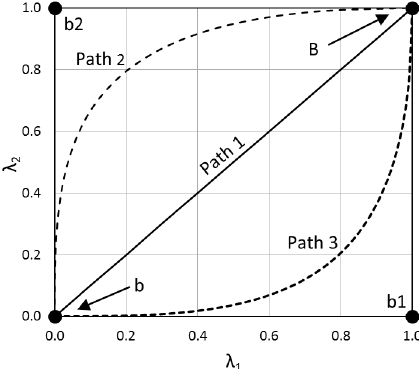
Figure 1. Three possible integration paths when the concentration difference between the base (point B) and background (point b) cases is allocated to two sources with emissions scaled by λ 1 and λ 2 . Path 1: equal control of emissions from both sources (diagonal path). Path 2: emphasis on control of emissions from source 1 first followed by control of emissions from source 2. Path 3: opposite of Path 2. Points b1 and b2 have the emissions from the background case plus source 1 and source 2,